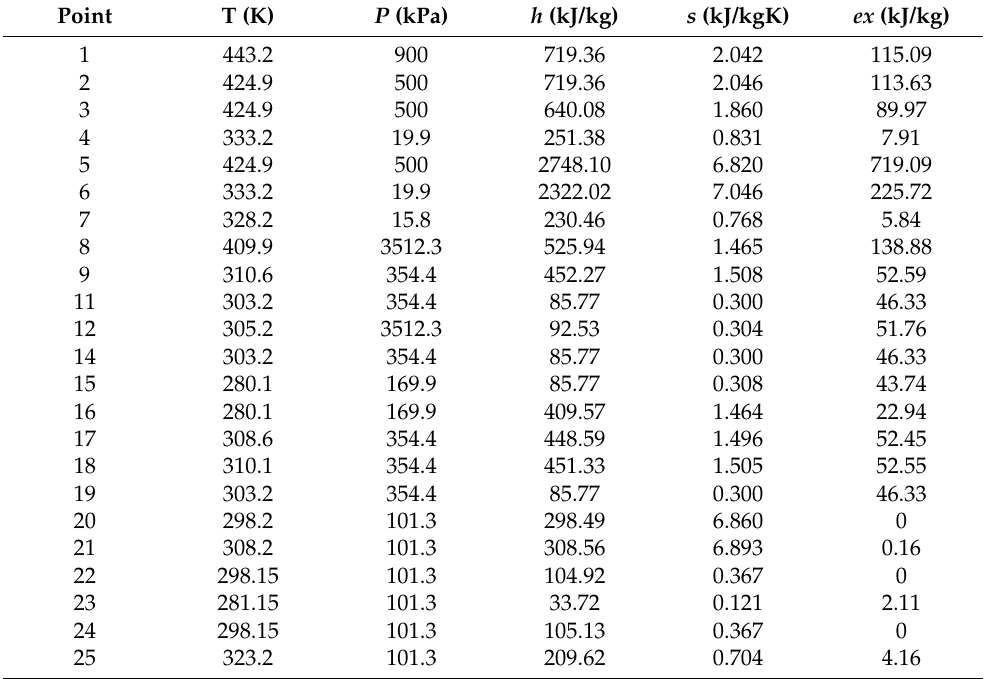
Table 12. The thermodynamic properties of the cycle.